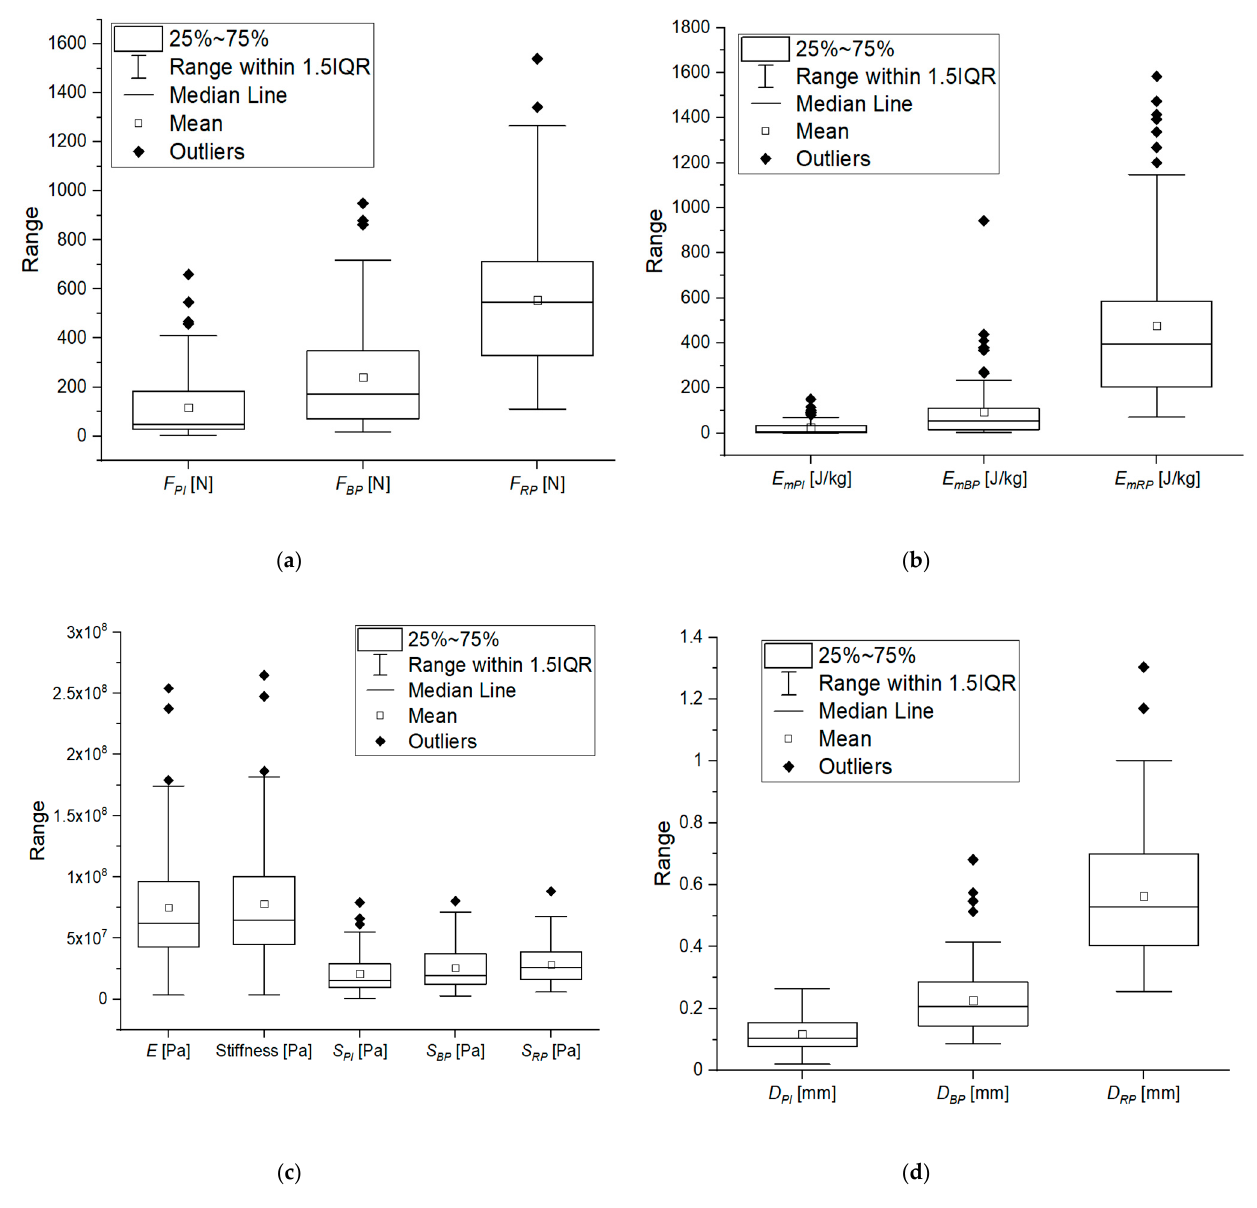
Figure 8. Box charts of strength parameters for corn grains determined in a compression test, ( a ) forces: F PI corresponding to point of inflection, F BP corresponding to bioyield point, F RP causing breakage, ( b ) specific energy: E mPI corresponding to point of inflection, E mBP corresponding to bioyield point, E mRP needed to break the grain, ( c ) young modulus E , stiffness and stresses: S PI corresponding to point of infection, S BP corresponding to bioyield point, S RP corresponding to grain breakage, ( d ) deformation: D PI corresponding to point of inflection, D BP corresponding to bioyield point, D RP corresponding to grain